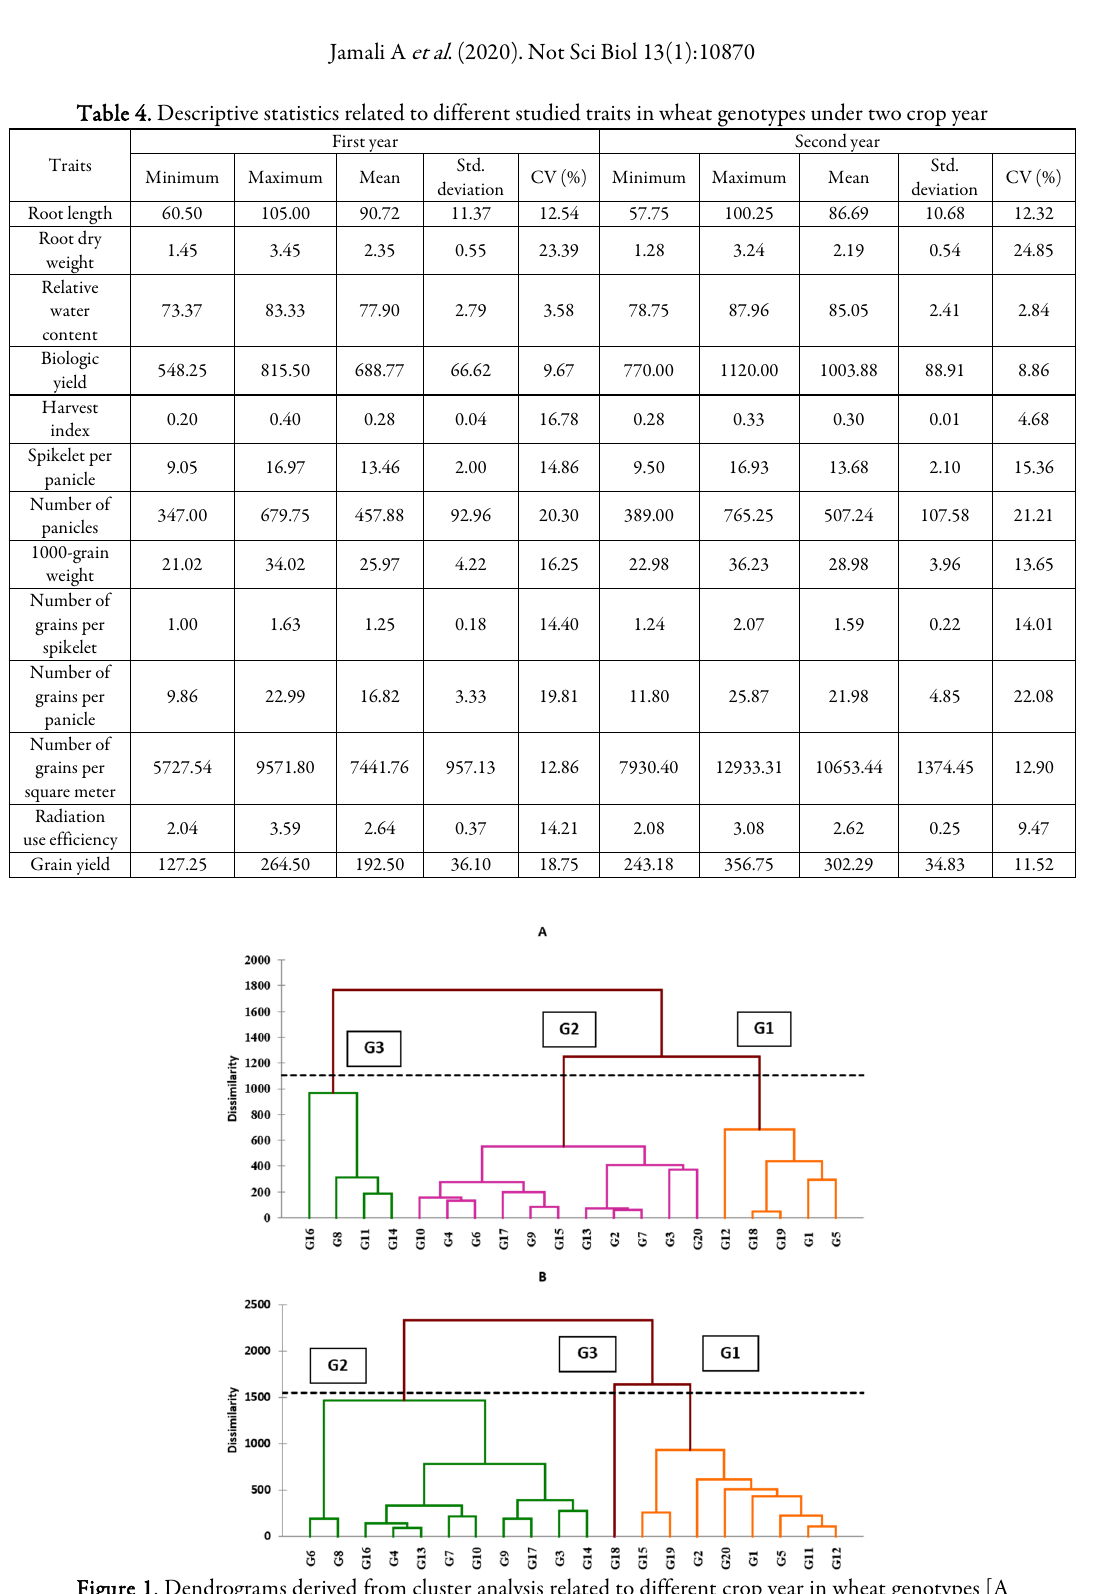
Figure 1. Dendrograms derived from cluster analysis related to different crop year in wheat genotypes [A (first year) and B (second